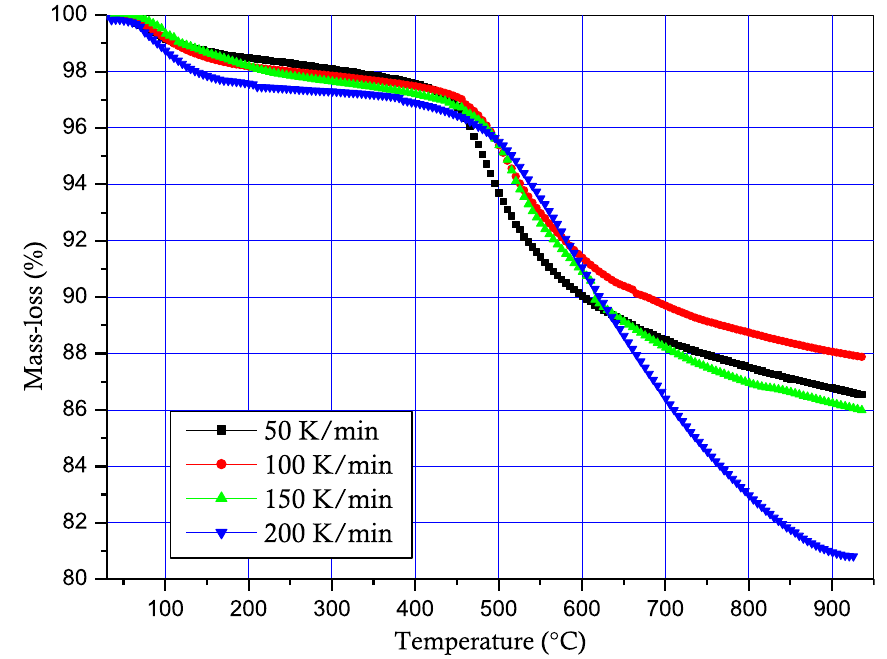
Fig. 9 TG curves at different heating rates on low rank coal pyrolysis process